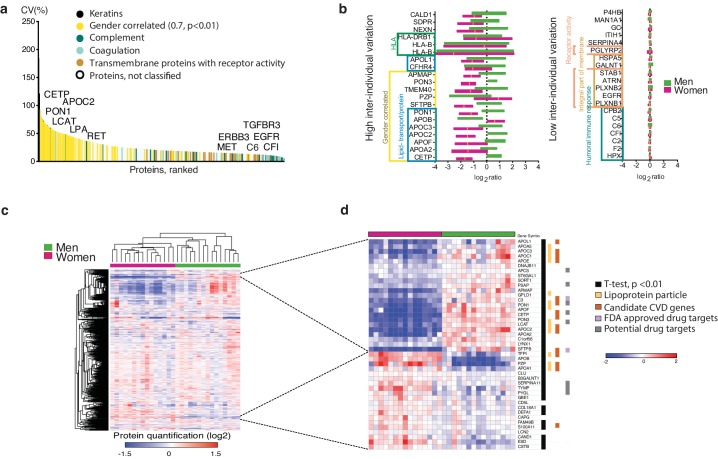
Plasma proteome inter-individual variability.(a) The plot shows the coefficient of variation (CV%) of 1080 plasma proteins detected across 30 blood donors, arranged from high to low CV(%). The largest variation was observed among keratins (known common contaminants that were excluded from downstream analyses) and gender-correlated proteins, which by gene ontology (GO) enrichment analyses were identified as enriched for lipoproteins. In contrast, complement and coagulation cascade proteins showed low inter-individual variation. Further analysis of proteins with low inter-individual variation showed enrichment of integral membrane proteins (FDR q-value 7E-11) and receptor activity (FDR q-value, 2E-4), for example the transmembrane receptors EGFR and TGFB3R. The variation did not increase with protein abundance level (Figure 2—figure supplement 1). (b) Bar graph showing the 20 proteins with the highest and 20 proteins with the lowest inter-individual variation across all subjects, categorized according to GO annotation and gender-correlated differential expression. All gender-correlated proteins were also statistically-significant when comparing men and women (Student's t-test p<0.01, FDR 1%, not assuming equal variance). (c) Heatmap showing unsupervised clustering of all 1080 proteins with overlapping quantification across the 30 plasma samples. The plasma proteins (log2-transformed ratios relative to a pooled internal standard composed of an aliquot of all 30 samples, rows) and the individual samples (columns) were sorted by hierarchical clustering (Pearson correlation, average linkage), with gender appearing to have the strongest impact on the upcoming clusters. In (d) is shown a zoom-in of the gender-correlated clusters (selection indicated by dashed lines). Indicated are lipoproteins, cardiovascular disease (CVD) genes, and potential- as well as FDA-approved drug targets. Indicated are also proteins with a statistically significant gender-specific differential expression.